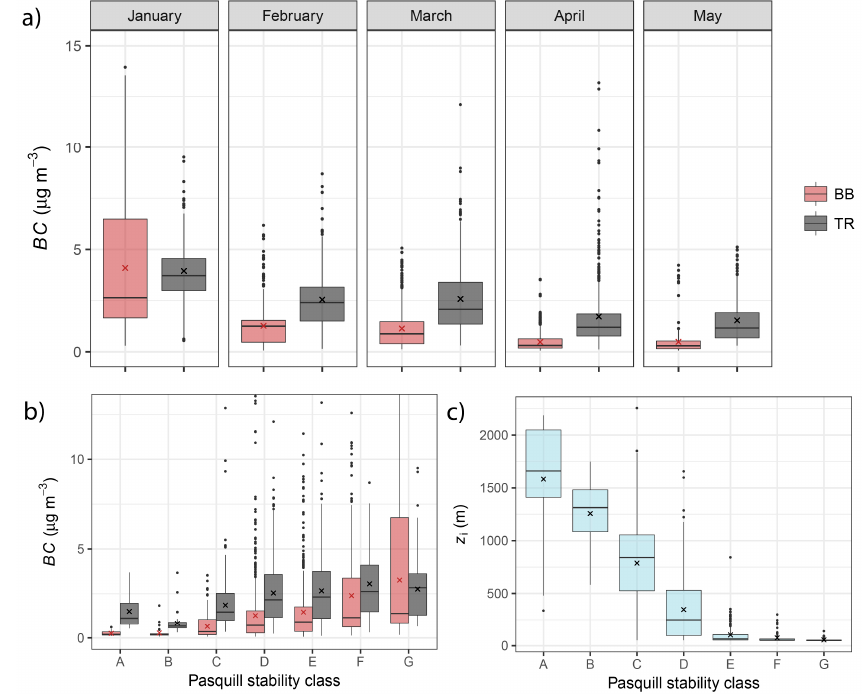
Figure 4. ( a , b ) Summary statistics of BC (Black Carbon) concentration measured at site A apportioned to traffic (TR) and biomass burning (BB) presented with box plots for each month separately ( a ), and grouped in PSQ (Pasquill stability class) stability classes A–G ( b ); ( c ) summary statistics of PBL (planetary boundary layer) height ( z i ) grouped in PSQ stability classes A–G. (box: range between 25th and 75th percentile, central line: median, cross: mean, dots: outliers, upper and lower whiskers represent data within 1.5 × IQR (inter-quartile range) distance).